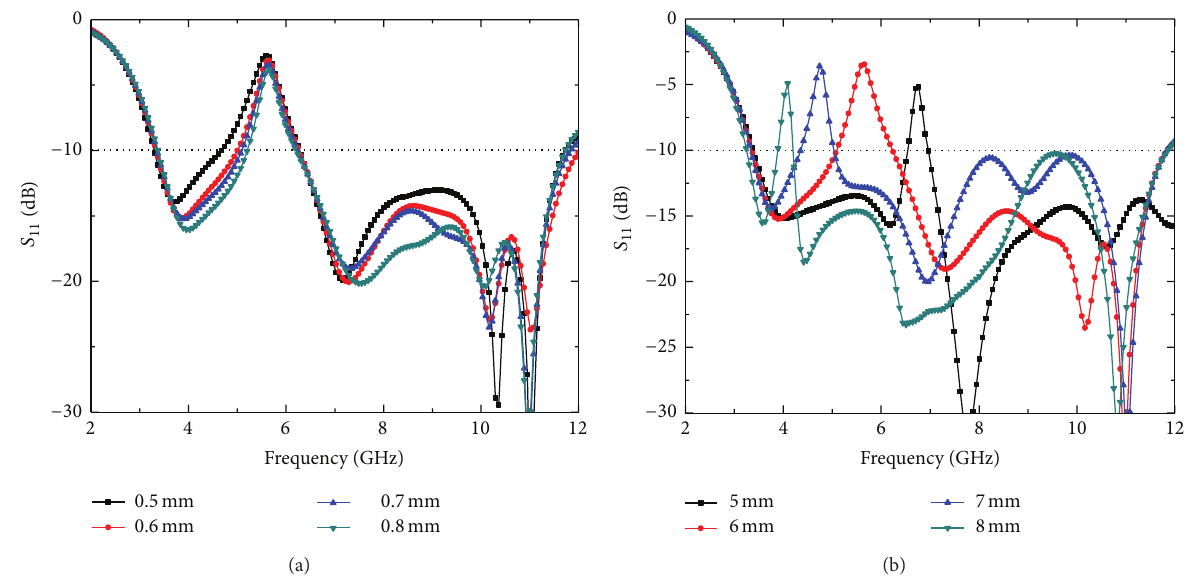
Figure 8: Simulated 𝑆 11 of the single UWB antenna integrated with EBG structures for different parameters of (a) 𝑔 and (b) 𝑤